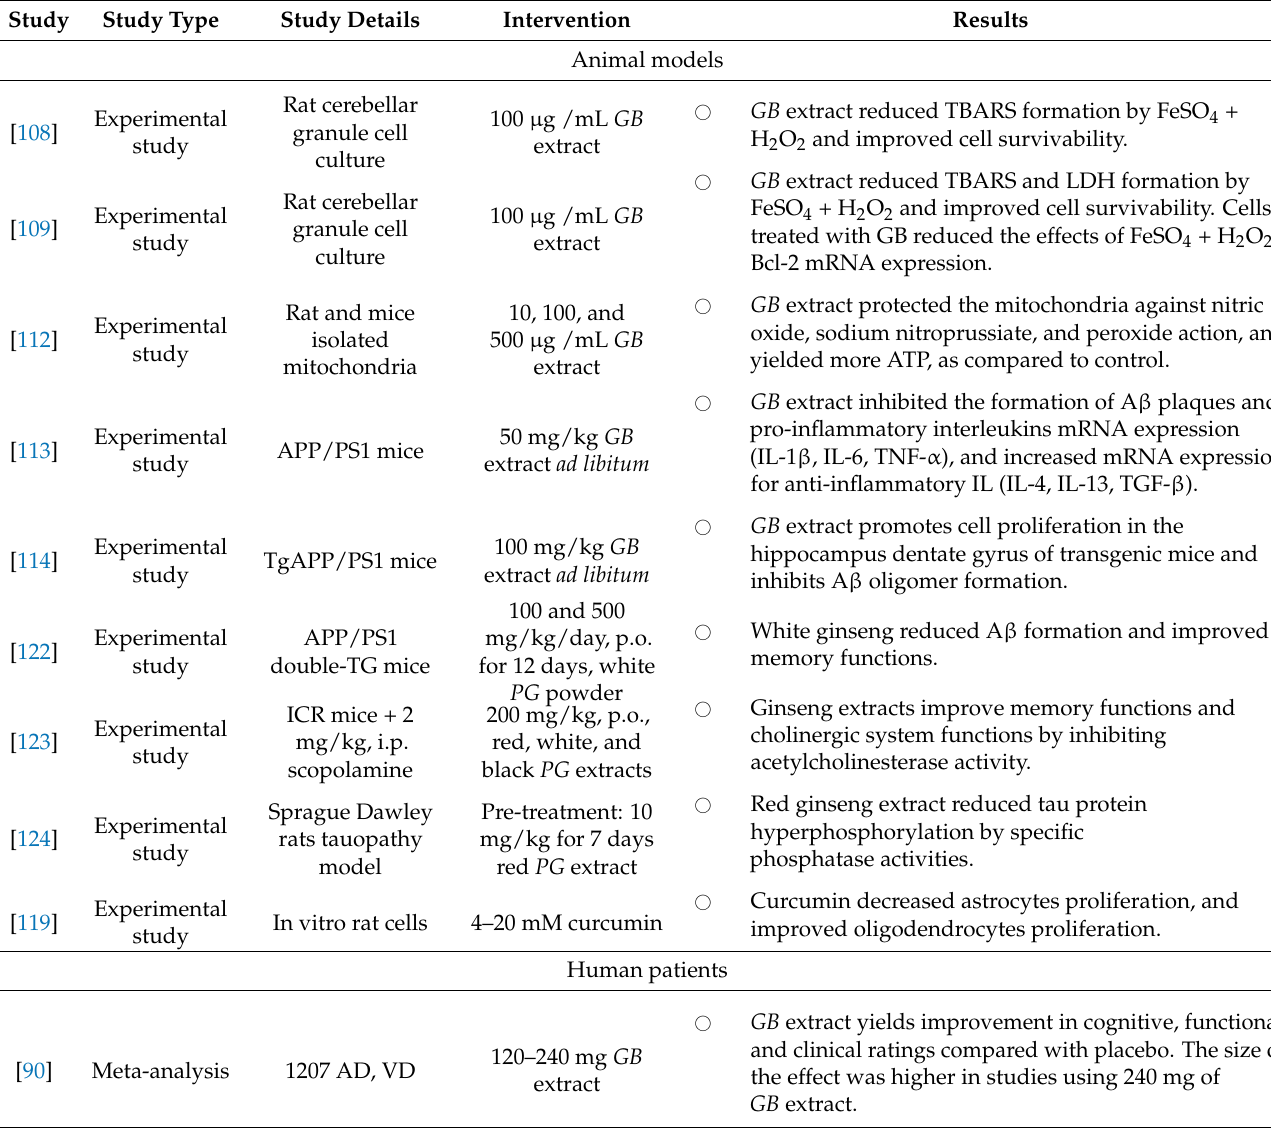
Table 4. The correlation between AD and some traditional medicines herbs’ neuroprotective